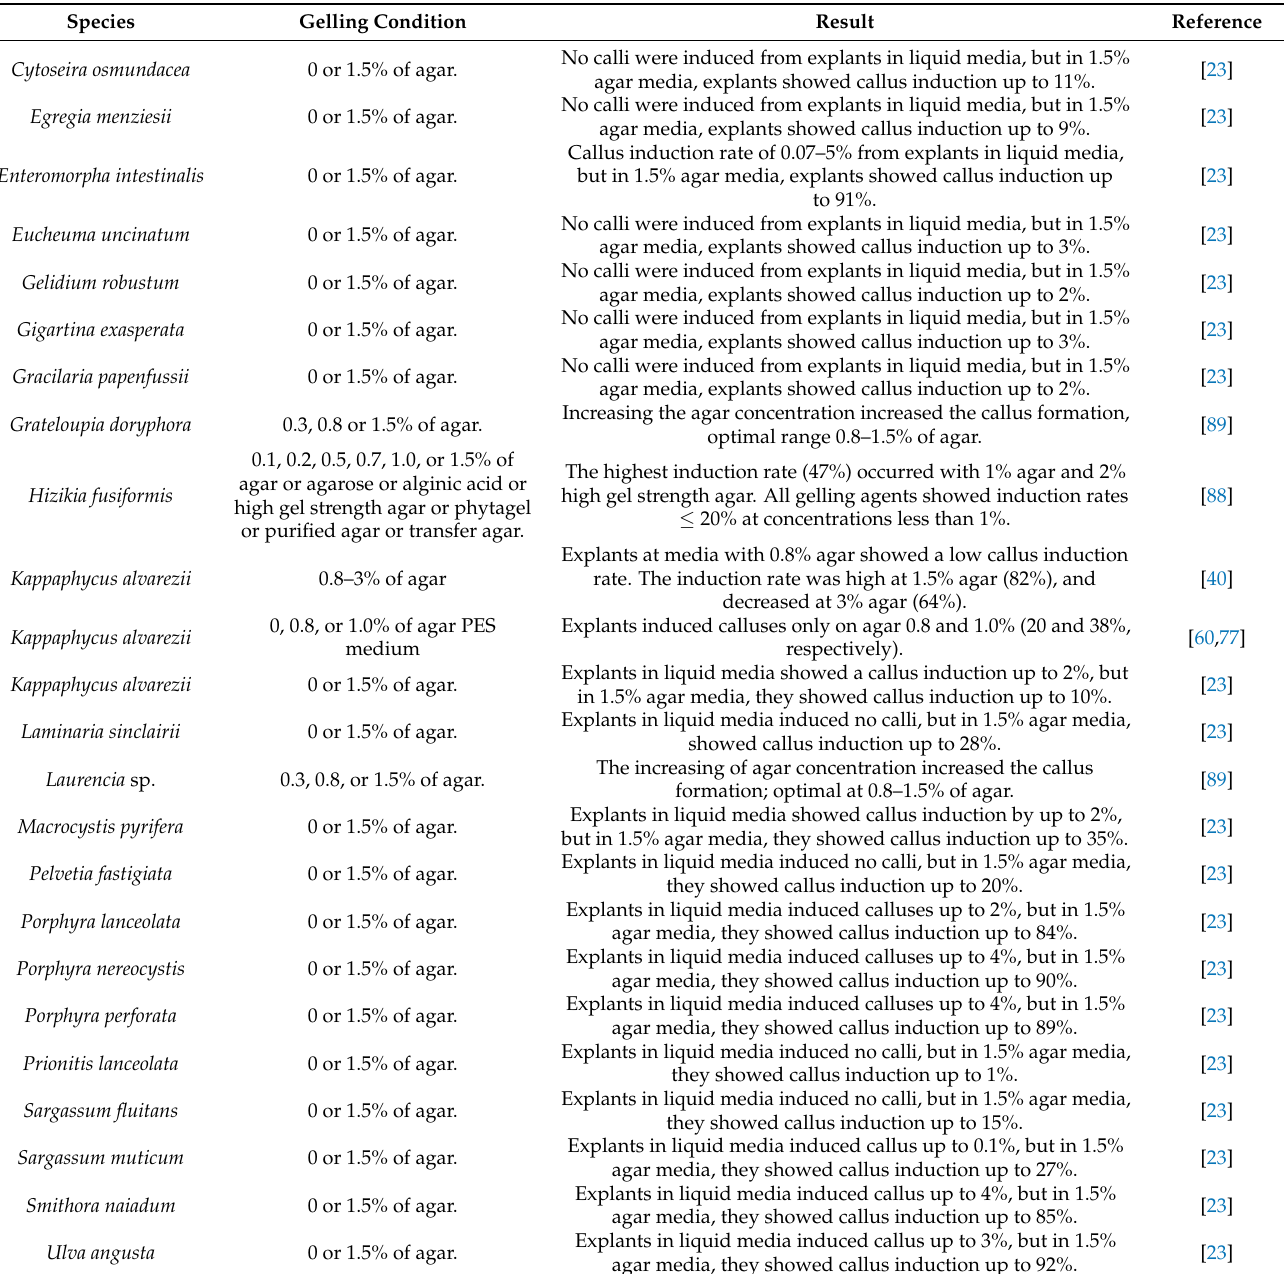
Table 5. Studies on the influence of gelling conditions on the callus induction of